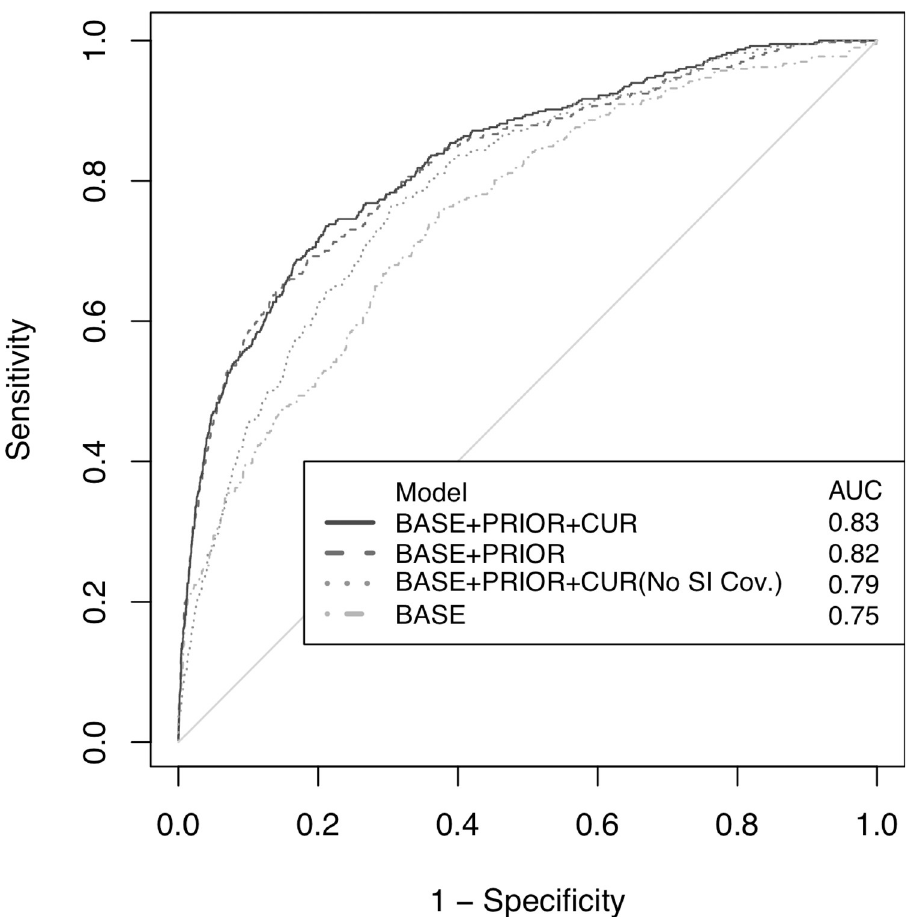
Fig 2. Receiver Operating Characteristic curves for prediction models of suicidal ideation during